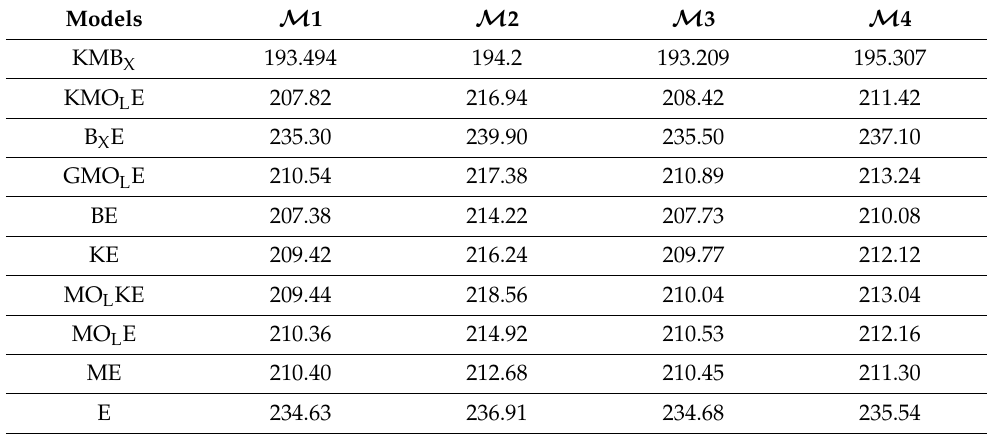
Table 8. Numerical values of M 1, M 2, M 3, and M 4 for the first data set.